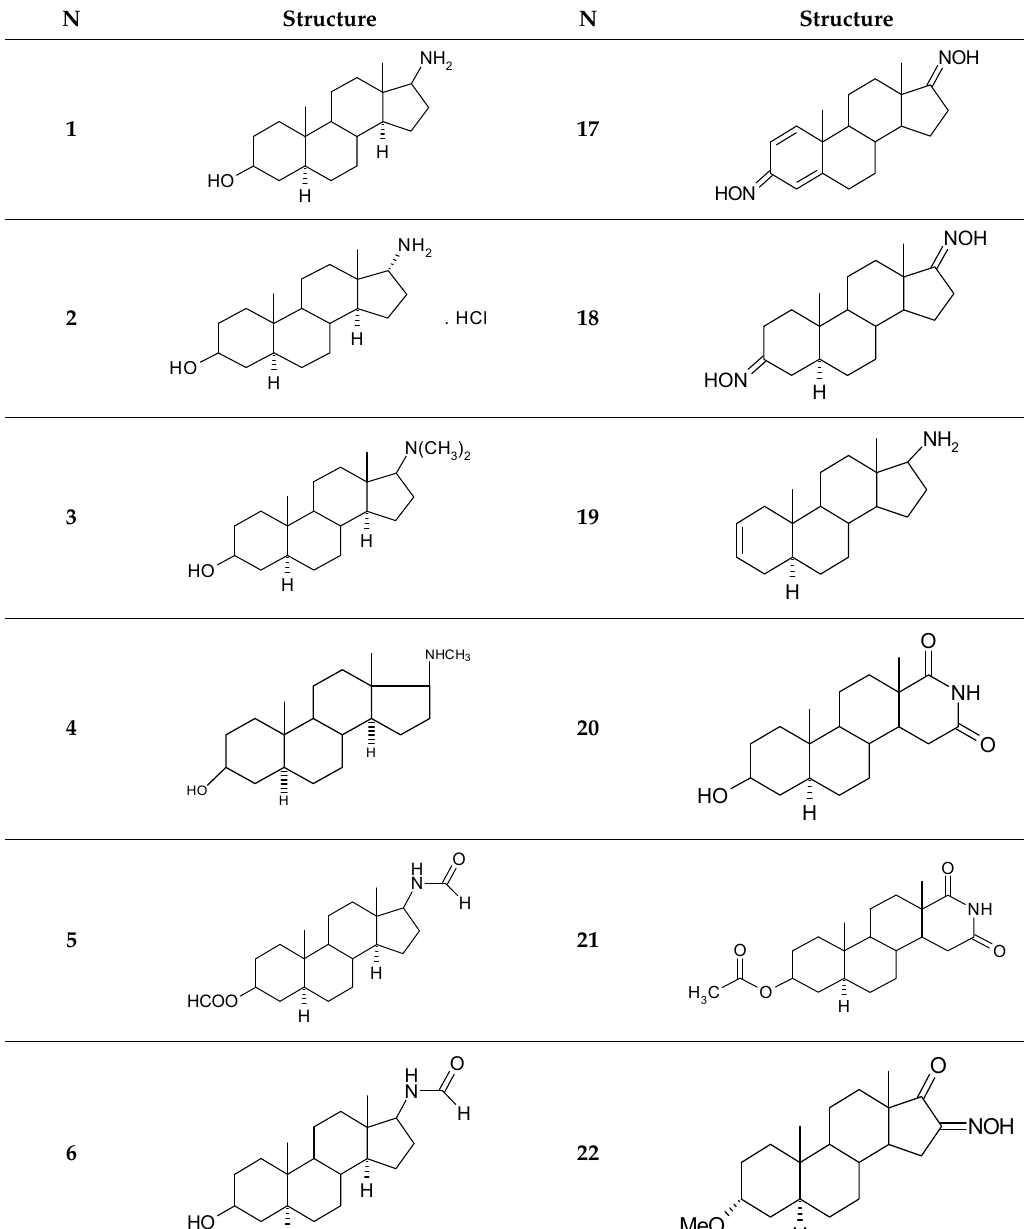
Table 1. Structure of compounds.